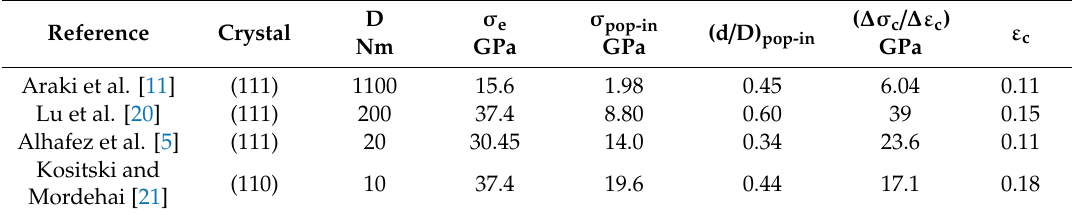
Table 1. Comparison of α -iron nano-indentation crystal hardness stresses and strain